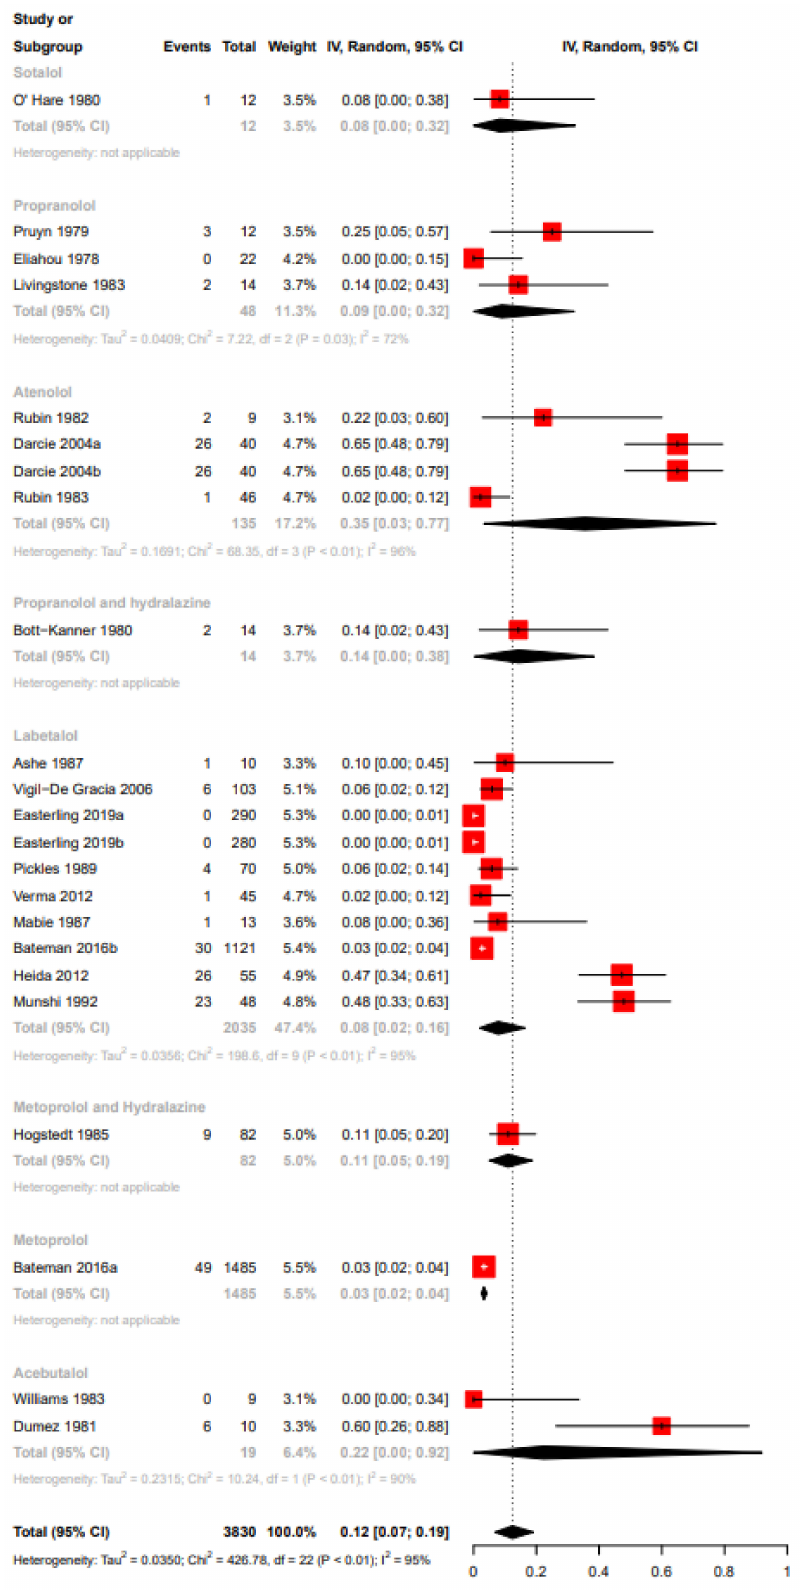
Figure 9. Proportion-based meta-analysis of hypoglycemia. Sotalol: [62]; propranolol: [55,64,65]; atenolol: [41,53,57]; propranolol and hydralazine: [61]; labetalol: [33,35,37,38,40,43,45–47]; metoprolol and hydralazine: [50]; metoprolol: [35]; acebutalol: